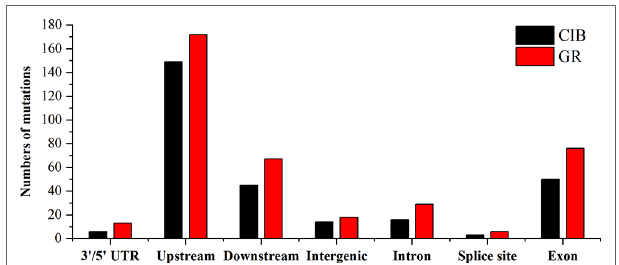
FIGURe 10 | The locations on the genome of mutations induced by CIB irradiation and